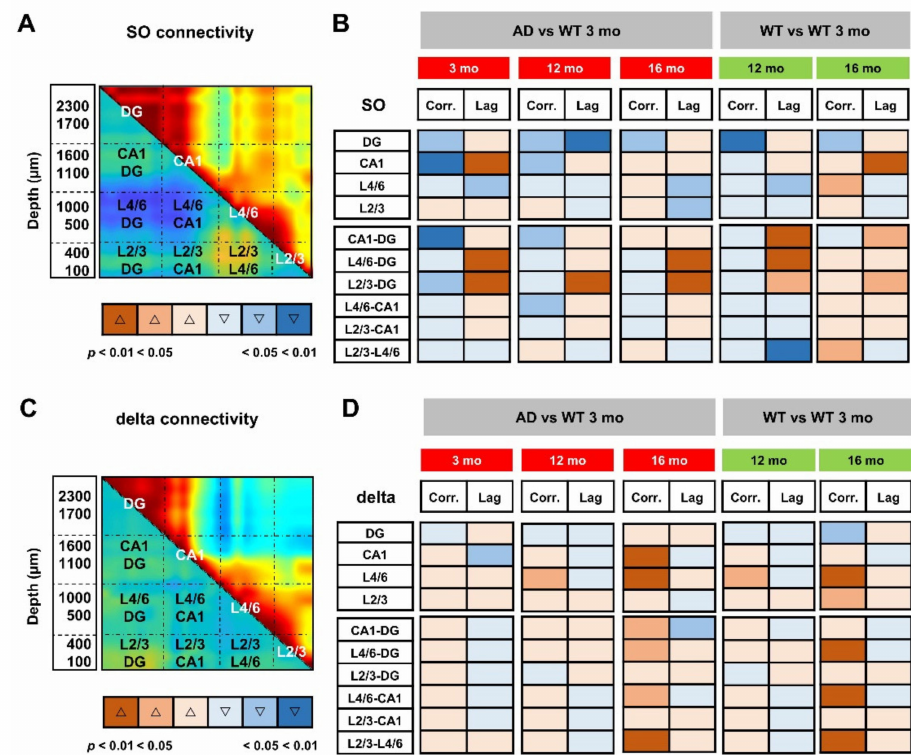
Figure 6. Loss of SO but not delta connectivity anticipates aging in young AD mice. For quantitative analyses of regional changes, maximal cross-correlation coefficients and latencies of each mouse were averaged within (intraregional) and between (cross-regional) regions, according to the scheme overlaid to the matrices of SO ( A ) and delta ( C ) connectivity in 3-month-old WT mice. ( B , D ) Synoptic views of the regional changes occurring in maximal cross-correlations and latencies at different ages in AD and WT mice. Warm and cold colors indicate increase and decrease, respectively. The color intensity reflects the level of statistical significance. Changes in regional cross-correlation coefficients and latencies are shown as boxplots in Supplementary Figures S7 and